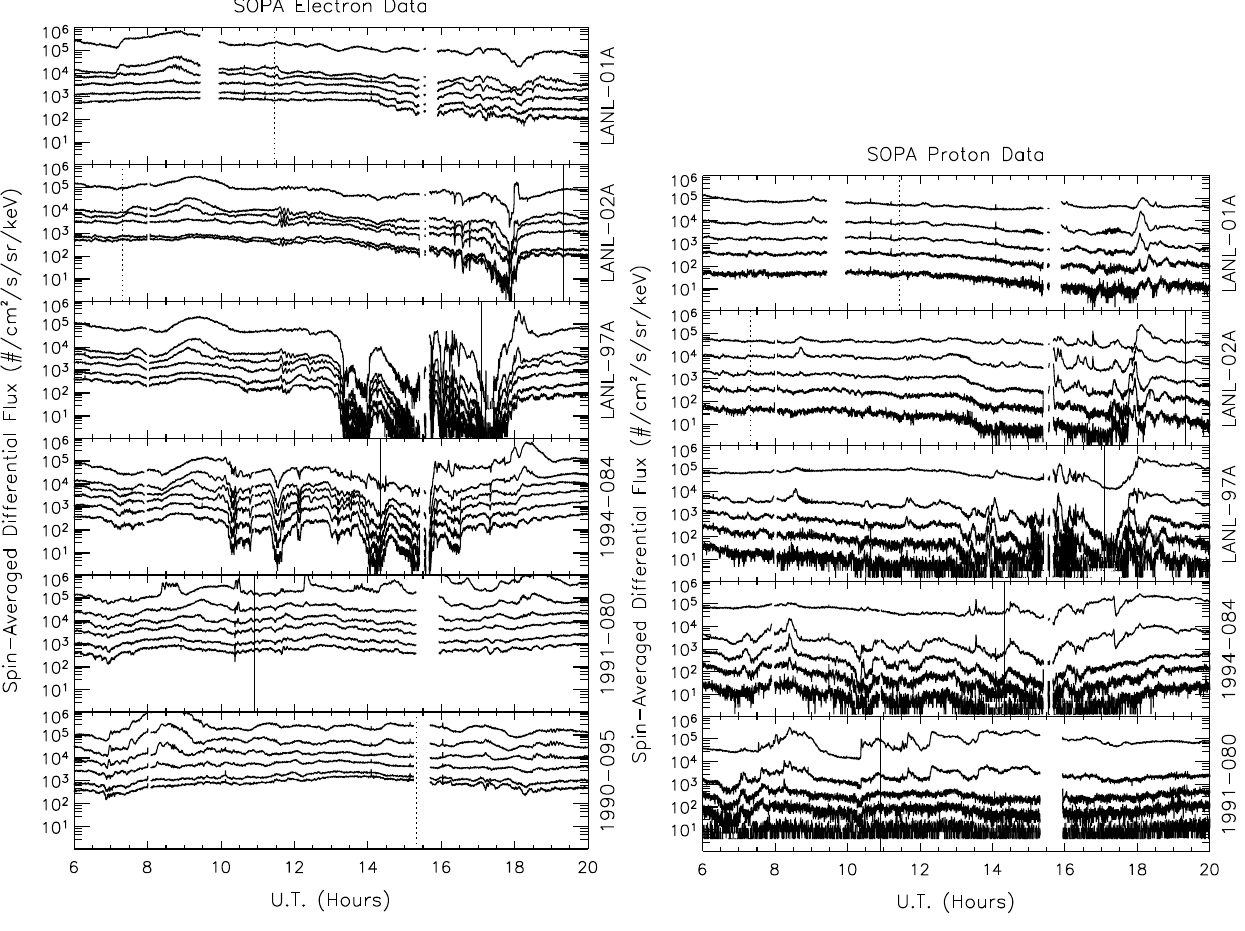
Fig. 2. (a) LANL SOPA spectra of spin-averaged differential electron fluxes measured at geosynchronous orbit during 06:00 to 20:00 UT, 30 November 2002. Each panel shows the results for a different satellite located at a different longitude. Continuous (dotted) vertical lines indicate when a satellite was located at local midnight (noon). The differential fluxes are shown on a logarithmic scale, with separate curves for each energy channel: 50–75KeV (top), 75–105KeV, 105–150KeV, 150–225KeV, 225–315KeV, and 315–500KeV (bottom) (b) The same except for the proton fluxes, with separate curves for each energy channel: 50–75KeV (top), 75–113KeV, 113–170KeV, 170–250KeV, and 250–400KeV